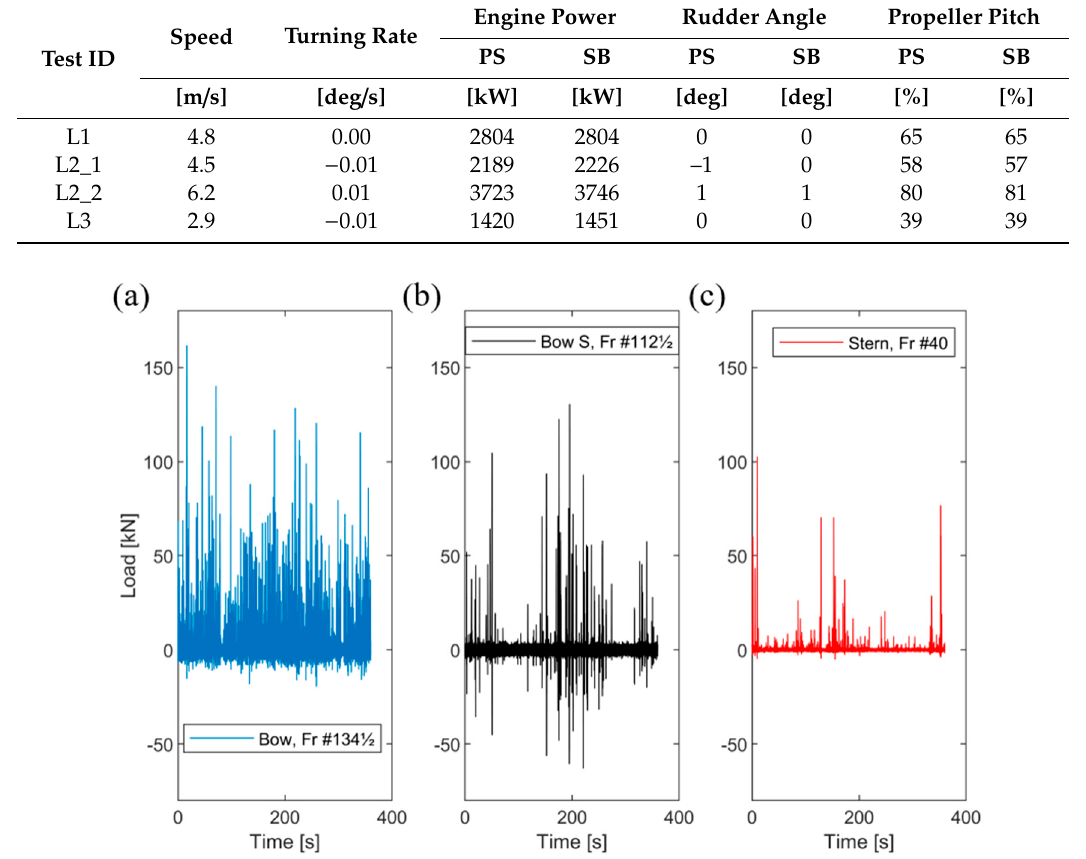
Table 5. Ship navigation and machine control data during straight-ahead tests.